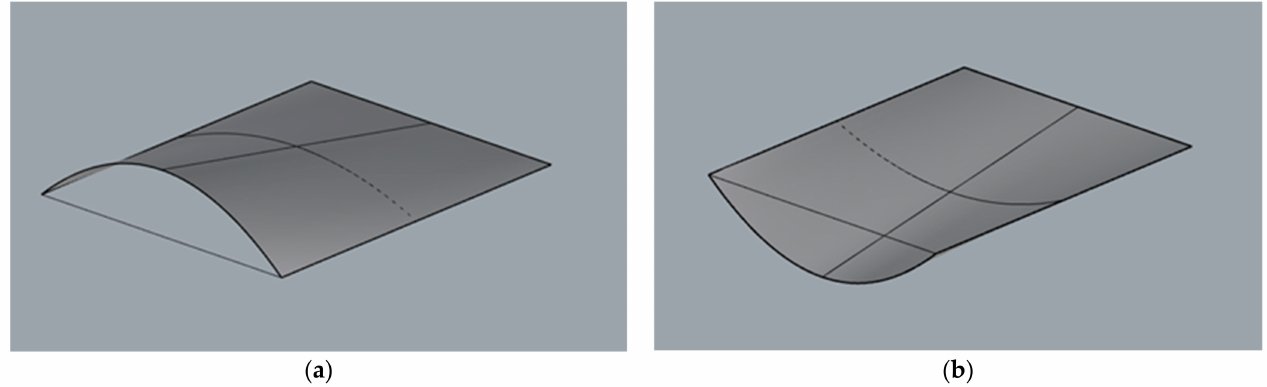
Figure 3. Example modules of conoid: ( a ) witch positive arch; ( b ) witch negative